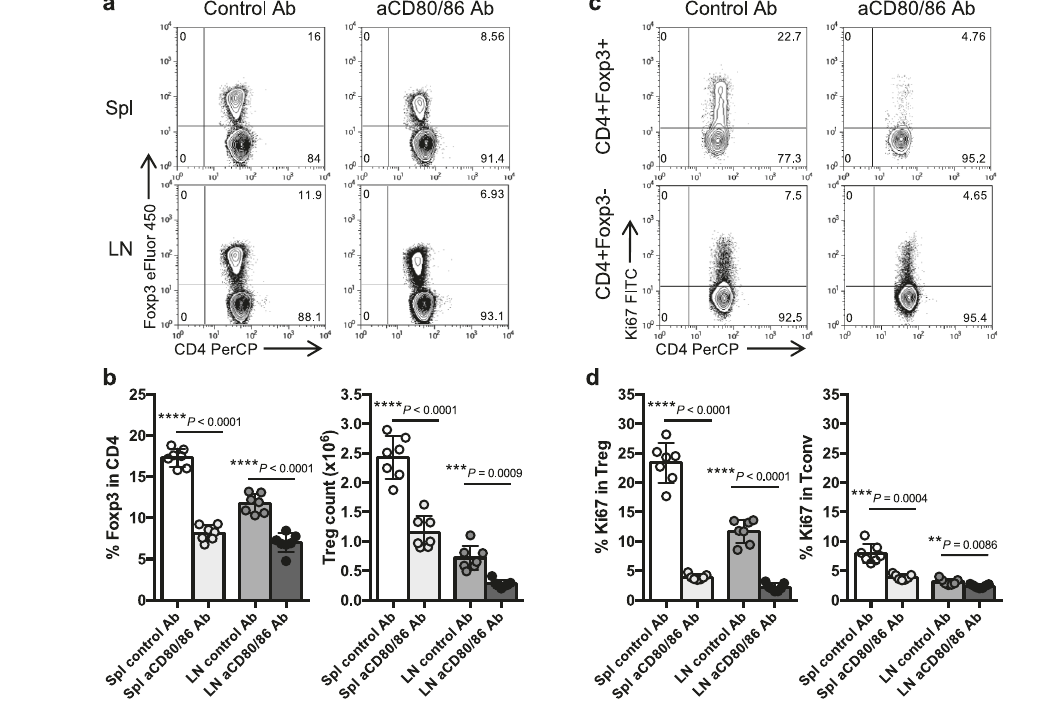
Fig. 1 | Impact ofCD28costimulation blockadeonTreg homeostasis. 6 – 9 week old BALB/c mice were injected i.p. with anti-CD80/86 Ab or control Ab on d0 and d6. At d8, spleen (Spl) and peripheral lymph node (LN) cells were harvested for analysis. a Representative FACS plots show Treg percentage in gated CD4+cells fromeitherspleen orperipherallymphnodes b .Collated data forTreg percentage (left)andTregabsolutenumber(right)( n =7pergroup).RepresentativeFACSplots